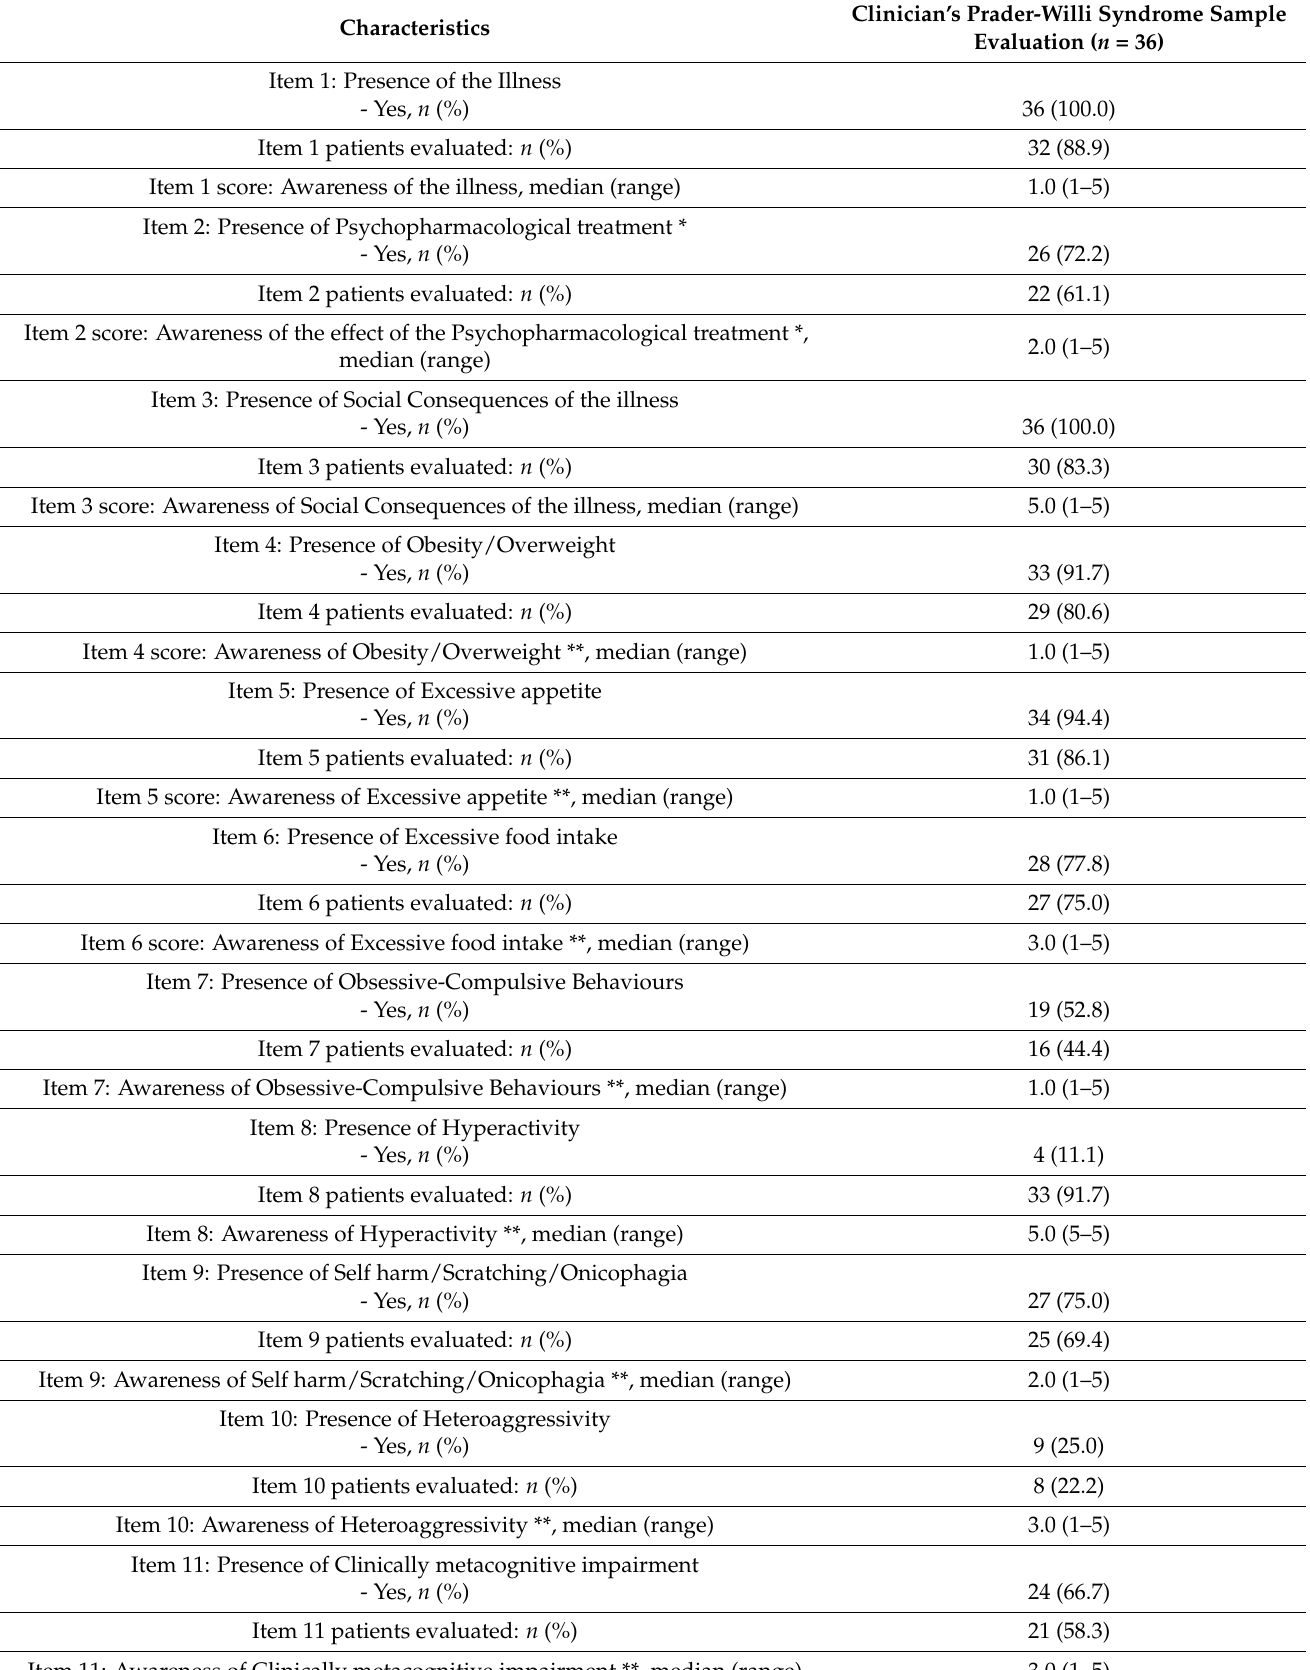
Table 2. Symptomatic profile and Awareness following the APW-SUD (Prader-Willi Syndrome sample).